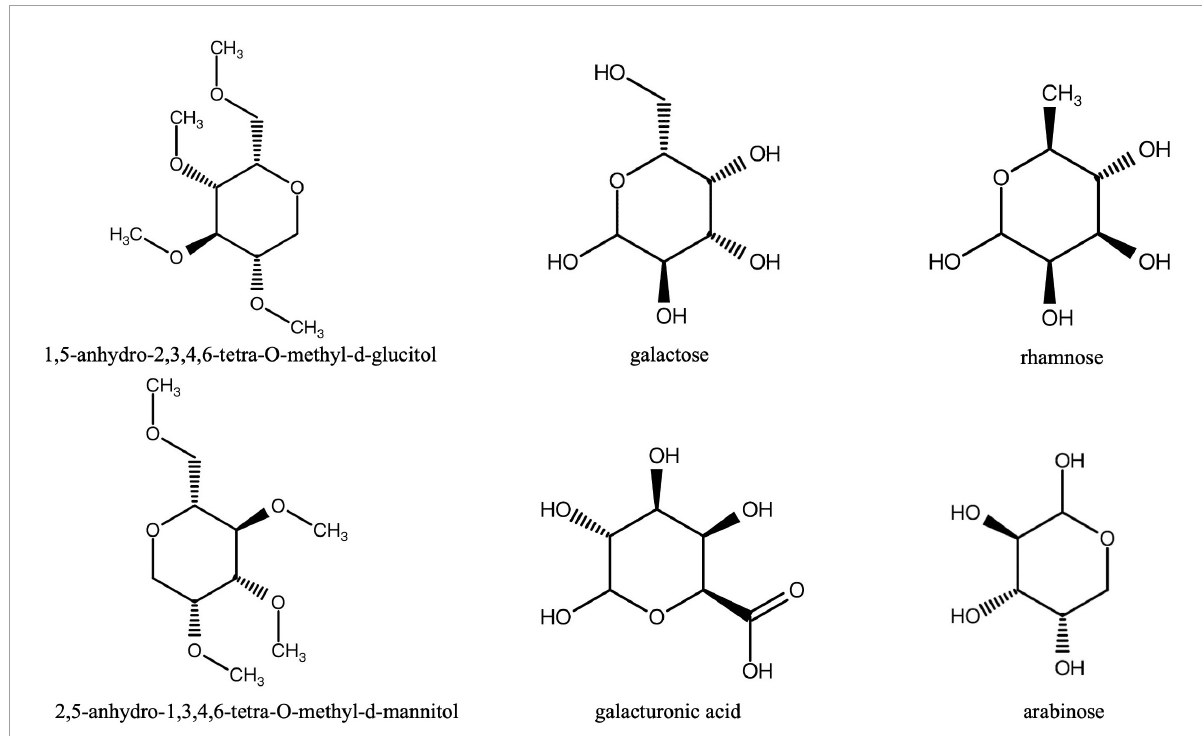
FIGURE1 The structures of the main polysaccharides (MP-1, MP-2, MP-3) in Morinda officinalis How.